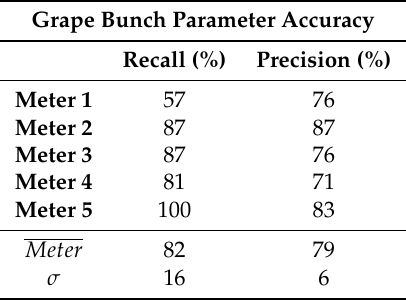
Table 4. Grape bunch recall and precision for yield parameter estimation of a VSP trellis grapevine row.